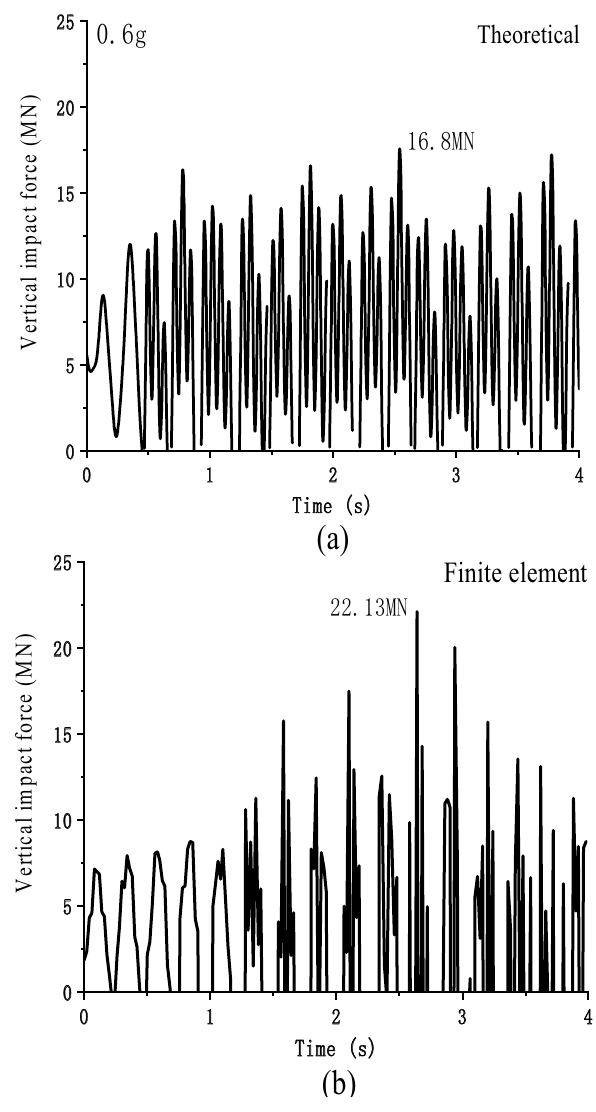
Figure 13. Vertical axial pressure of pier: ( a ) Theoretical solution; ( b ) Finite element